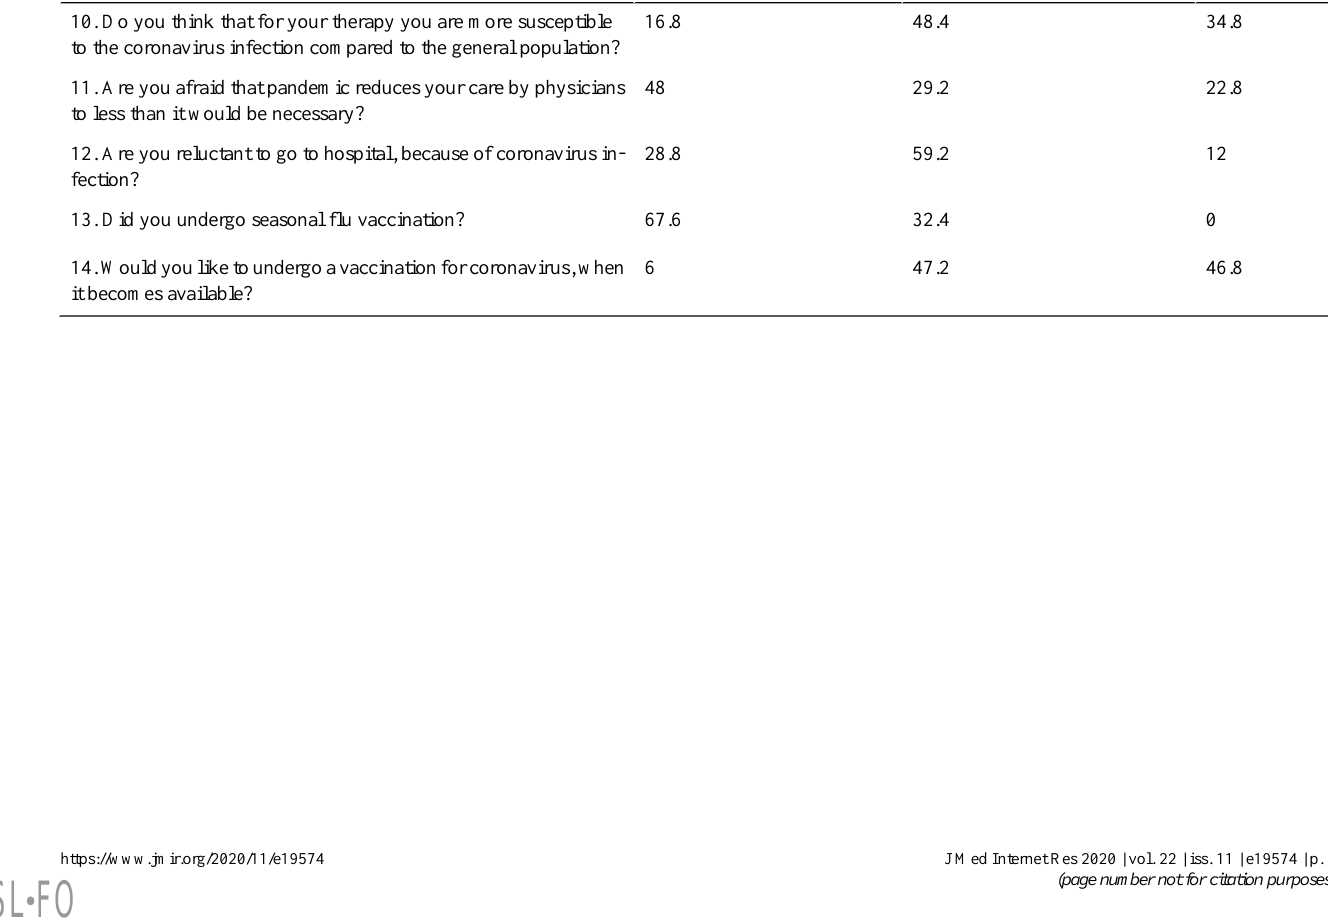
Table 3. Results of the survey administered to patients with inflammatory bowel disease for evaluating COVID-19 perception (Questions 10-14). 34.848.416.810. Do you think that for your therapy you are more